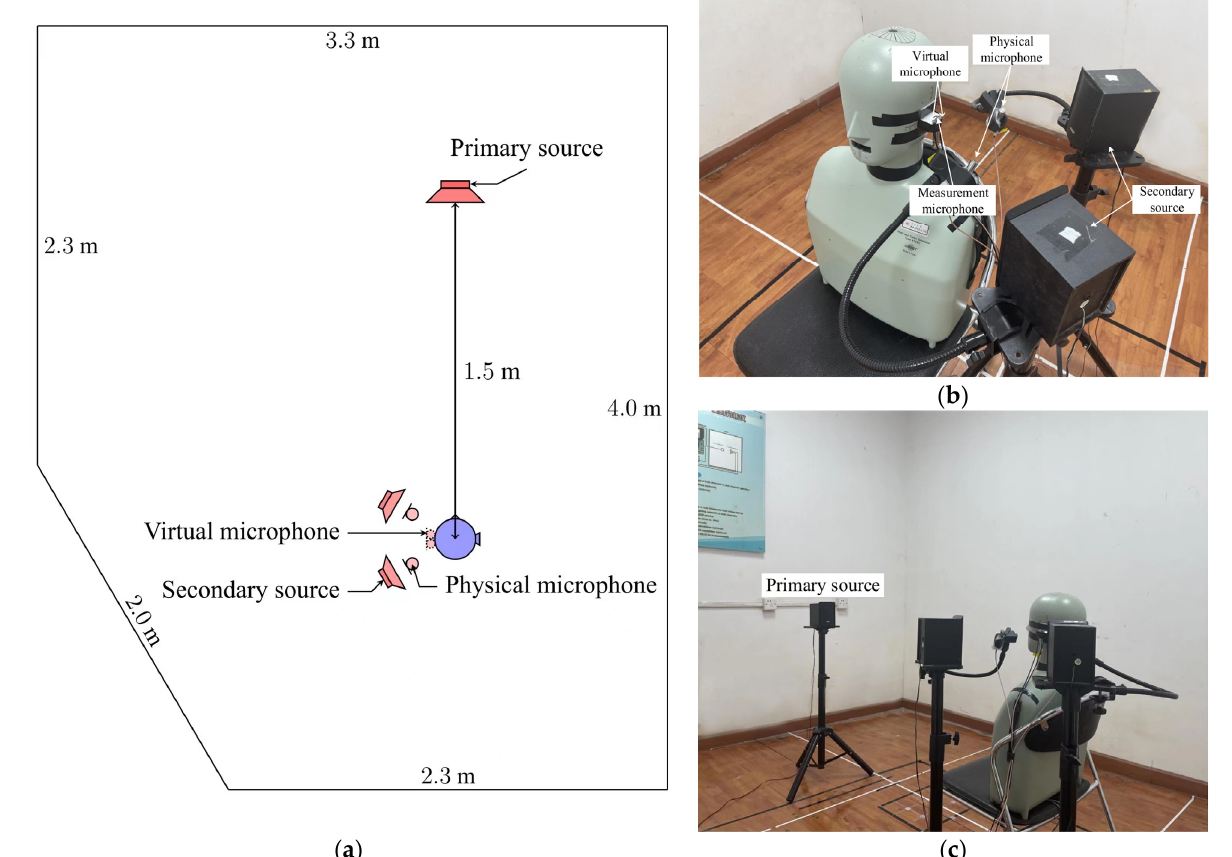
Figure 13. Diagram and photographs of the experimental setup ( a ) diagram of the experimental setup, ( b ) photograph of the ANC system, ( c ) photograph including primary source.